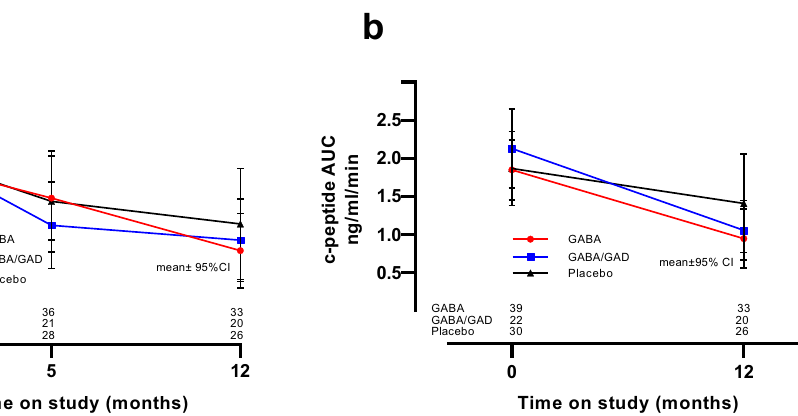
Fig. 2 | Fasting and AUC c-peptide in study groups over time. Fasting c-peptide ( a ) was measured in the three study groups (GABA-red, GABA/GAD-blue, and pla- cebo-black) at baseline (Time=0,prior any treatment) and at 1, 5 and 12-months thereafter. AUC c-peptide (b) was calculated over time in the three study groups.